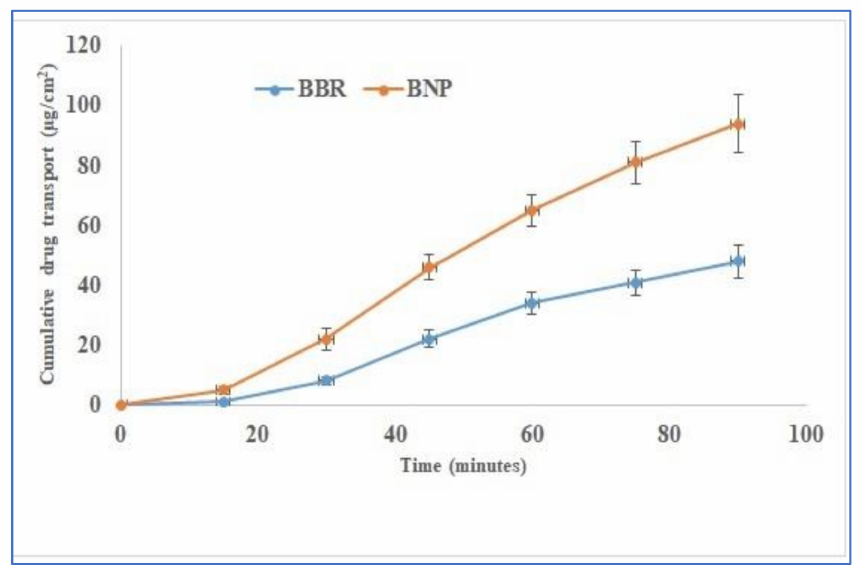
Figure 6. Ex vivo gut-permeation study showing comparative cumulative drug transport.